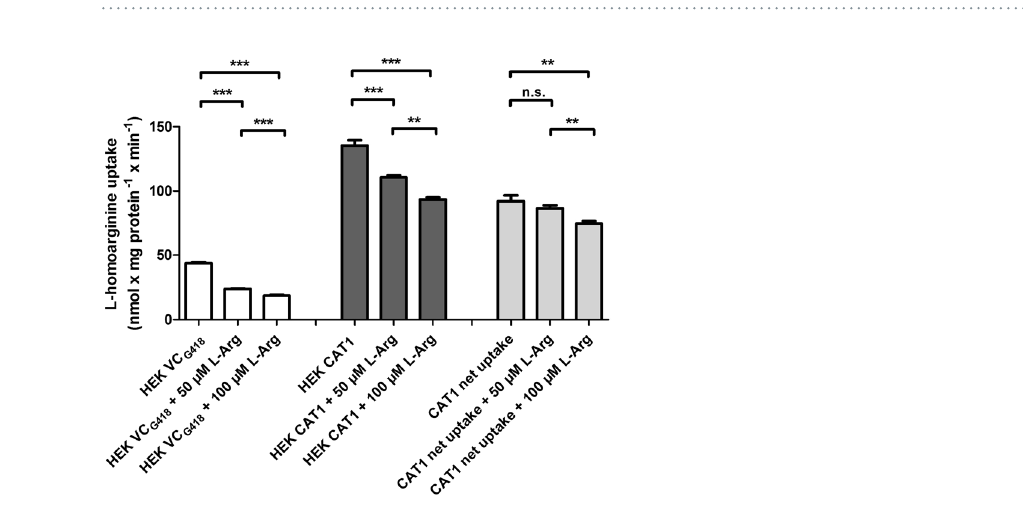
Figure 4. Inhibition of CAT1-, CAT2A-, CAT2B-mediated L-homoarginine (100 µ mol/l) uptake by increasing concentrations of L-arginine ( a , c , e ) and ADMA ( b , d , f ). Each data point is n = 6.